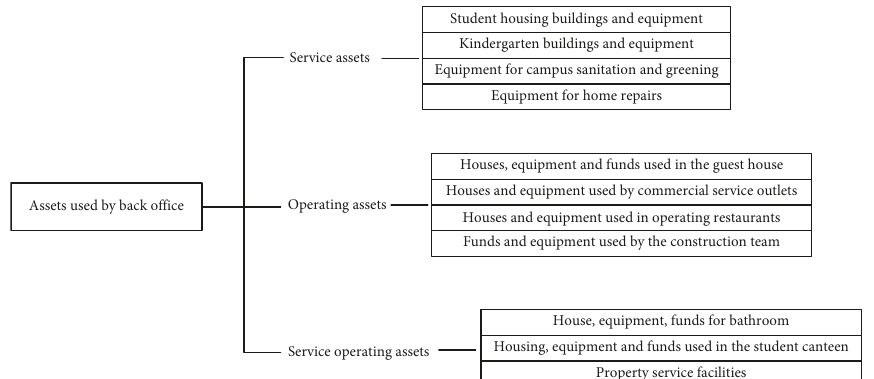
Figure 3: Classification diagram of assets used by logistic enterprises.